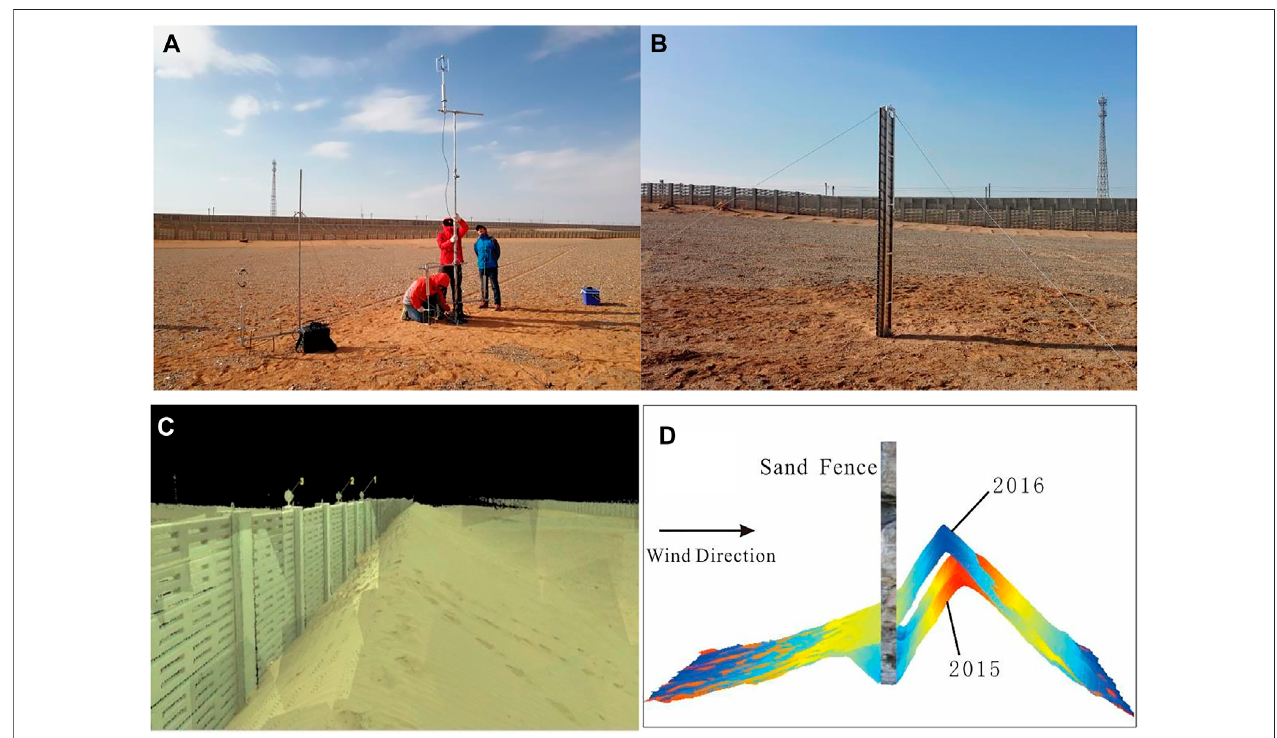
FIGURE 4 | (A) 3-D ultrasonic anemometers used to measure the wind pro fi les around the sand fences; (B) the sand sampler located windward of the fi rst sand fence row; (C) scanning image of the deposited sand dune, as captured by a 3-D laser scanner; and (D) DEM model of the dunes deposited, depicted in ArcGIS software.